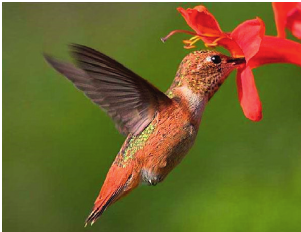
Figure 1: Hummingbirds can hover easily by changing the angle and shape of their wings and tail fin.